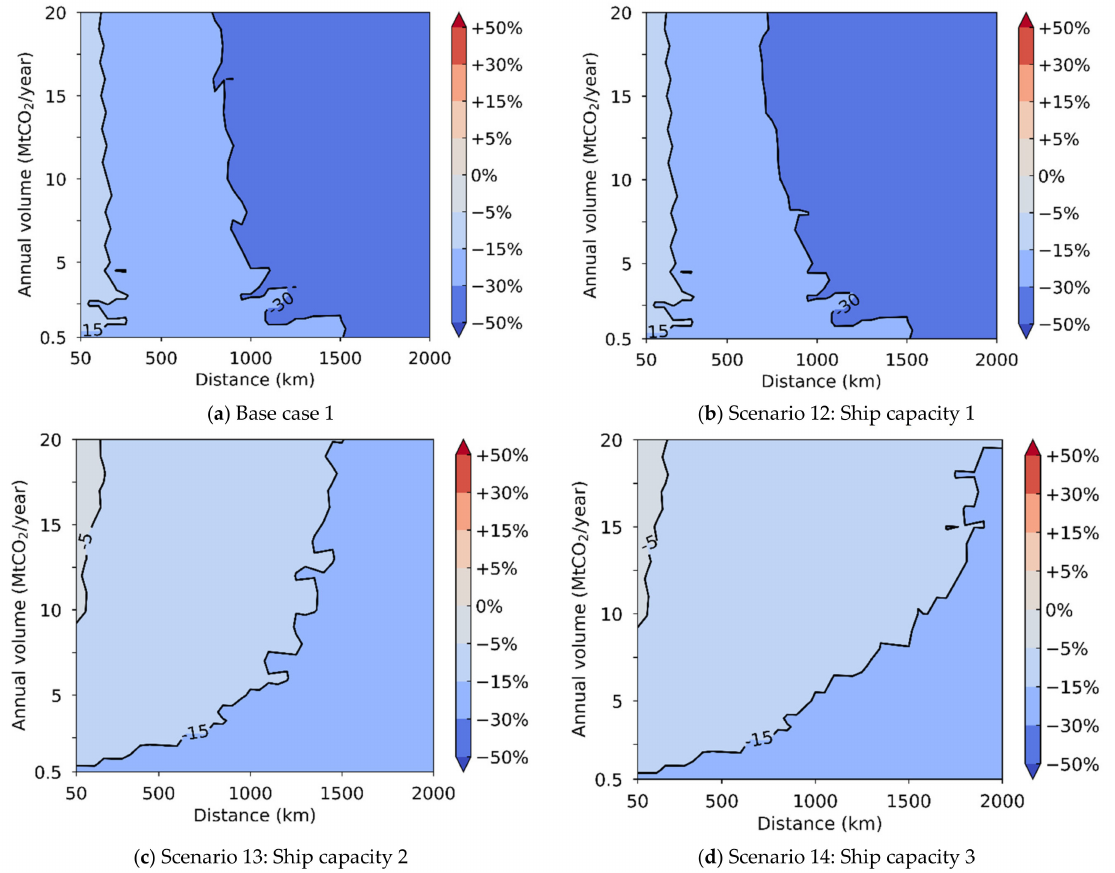
Figure 10. Cost comparison maps showing relative cost reductions (%) enabled by the 7 barg compared to the 15 barg shipping option in the case of ship transport between two harbours under different maximum ship capacity